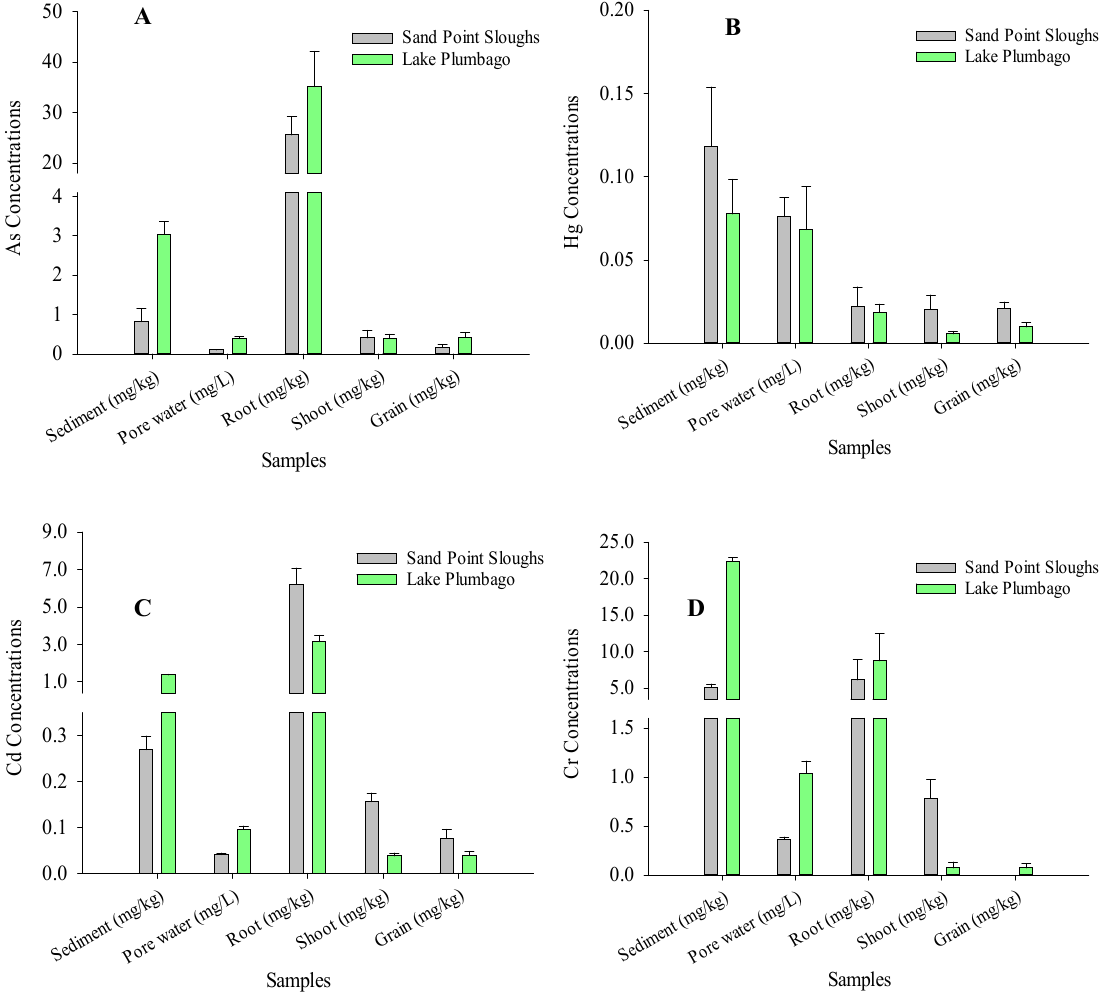
Figure 2. Total element concentrations in Sand Point sloughs and Lake Plumbago sediment, porewater, and wild rice samples. The concentrations are expressed as mg/kg for sediment and plant samples and mg/L in water samples. ( A ). Arsenic, ( B ). Mercury, ( C ). Cadmium, and ( D ). Chromium. Data are reported as mean ± S.D. ( n = 3).